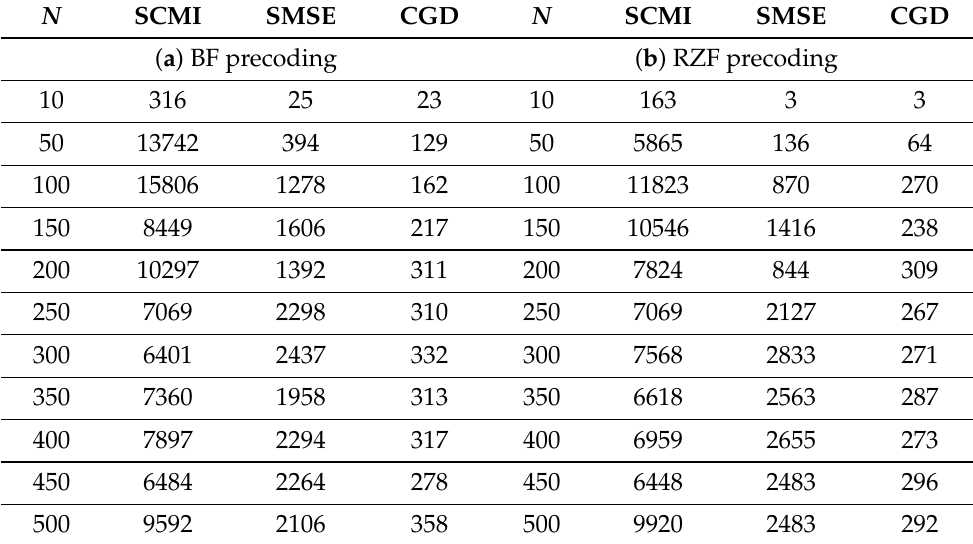
Table 4. The number of iterations per each training sequence algorithm required to converge with respect to the number of BS antennas N for the pilot length in BF and RZF precoding in the OR model with ω = 25 ◦ , D = 1, T = 100 symbols, ρ d = 10 dB and K = 10 users.